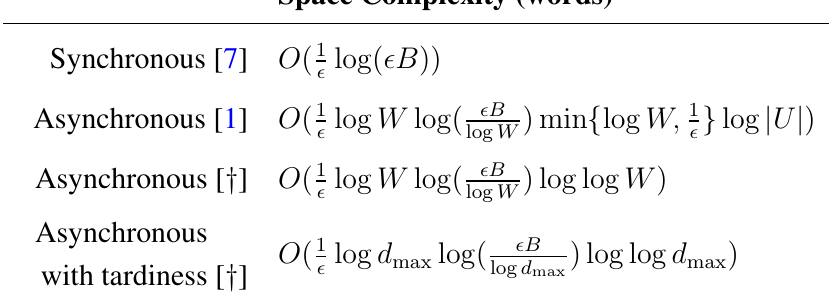
log d max (cid:15)